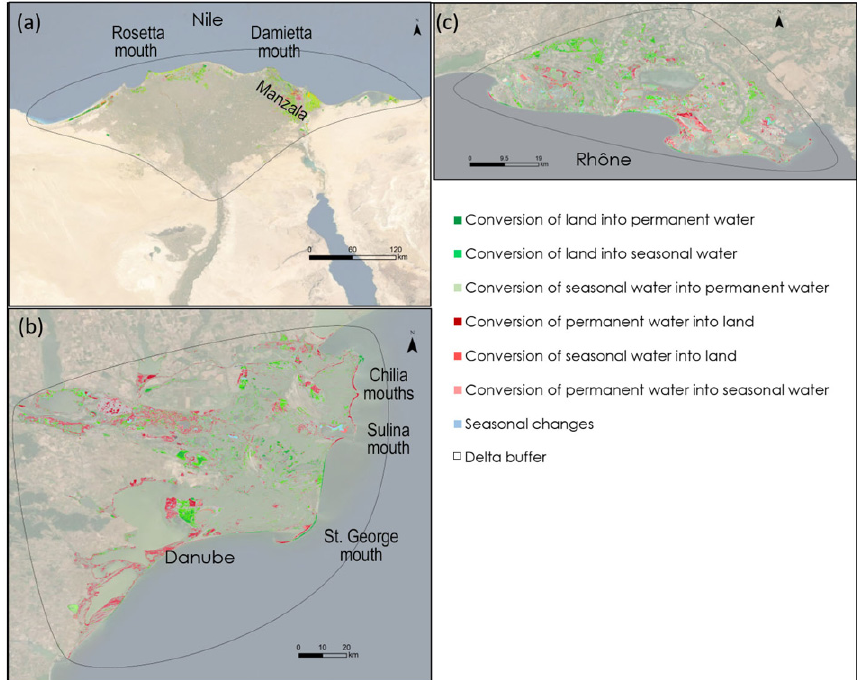
Figure 3. Maps of categories of land → water and water → land conversions for the Nile ( a ), Danube ( b ), and Rhône deltas ( c ), culled from the Global Surface Water (GSW) database [7]. The spatial pattern is largely dominated by delta-plain change (91%–95%). Basemap: Esri, DigitalGlobe, GeoEye, Earthstar Geographics, CNES/Airbus DS, USDA, USGS, AeroGRID, IGN, and the GIS User Community.